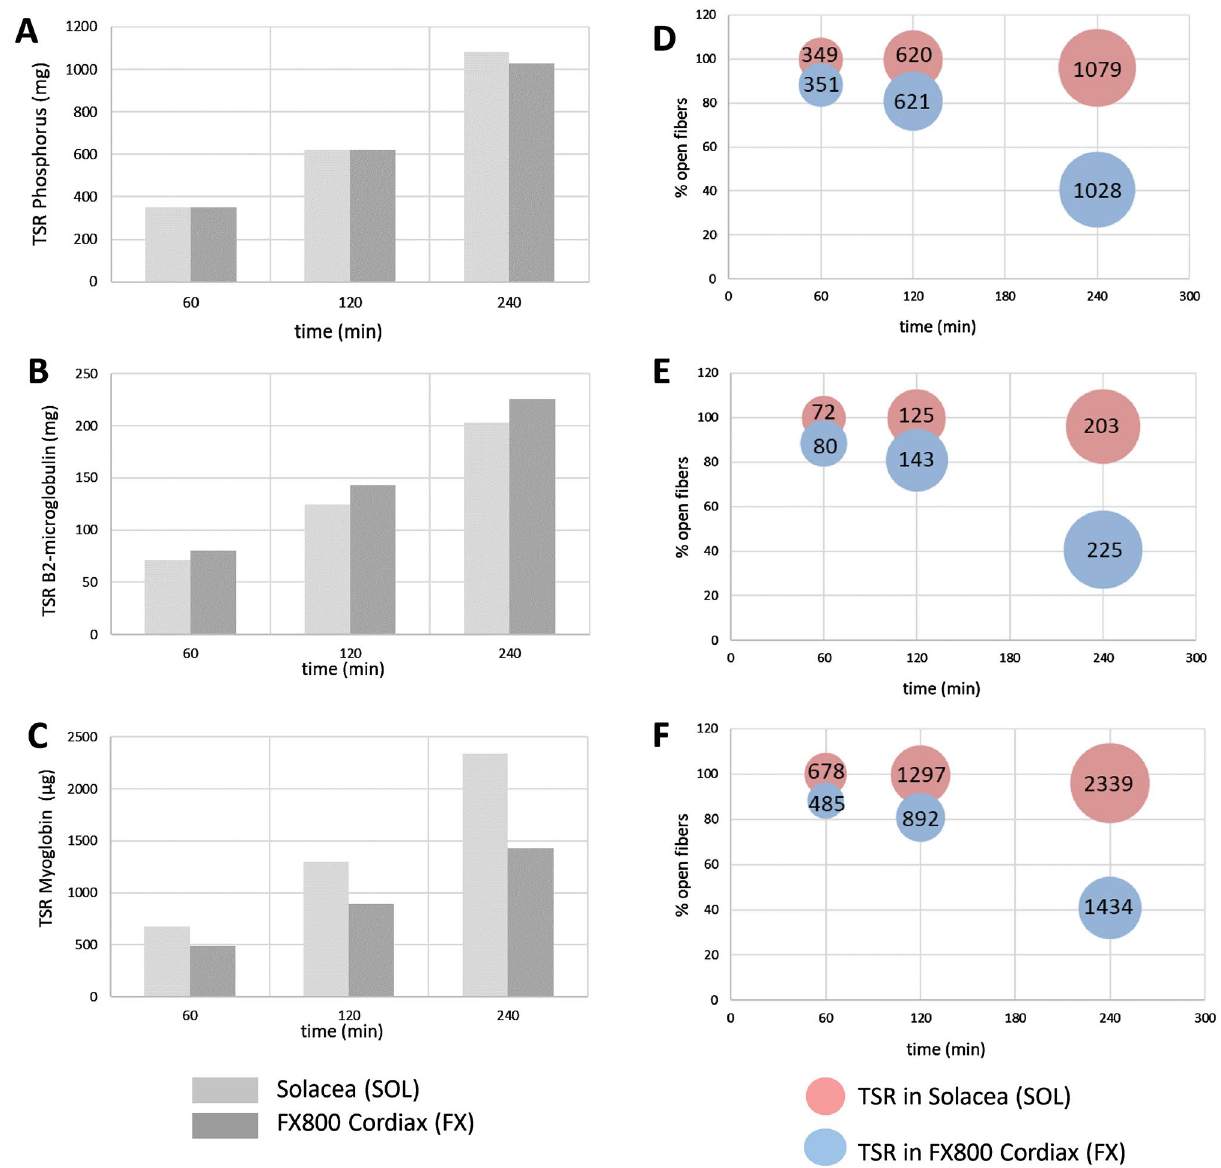
Figure 4. Total Solute Removal as theoretically calculated for a virtual patient, cumulated during dialysis (panels A – C ), and as an extra function of the percentage open fibers (panels D – F ) for phosphorus (panel